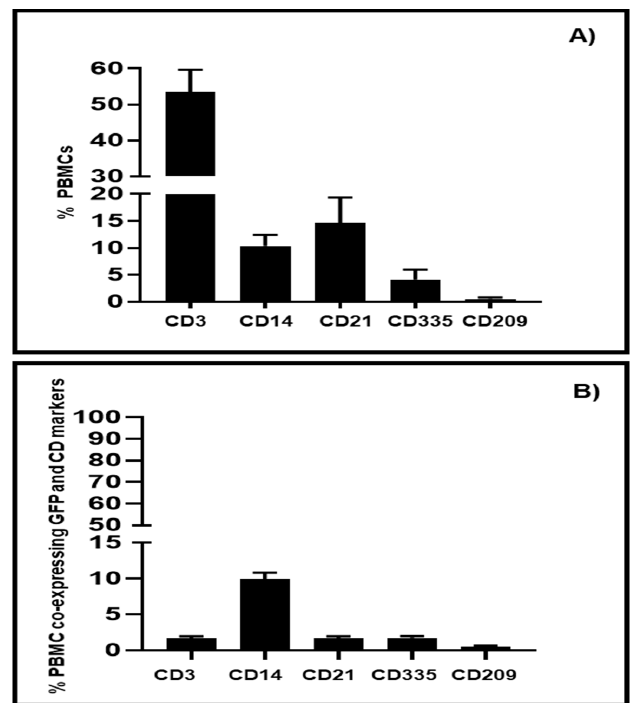
Figure 2. Transduction of leukocyte subpopulations by BAV304a. ( A ) Bovine PBMCs were